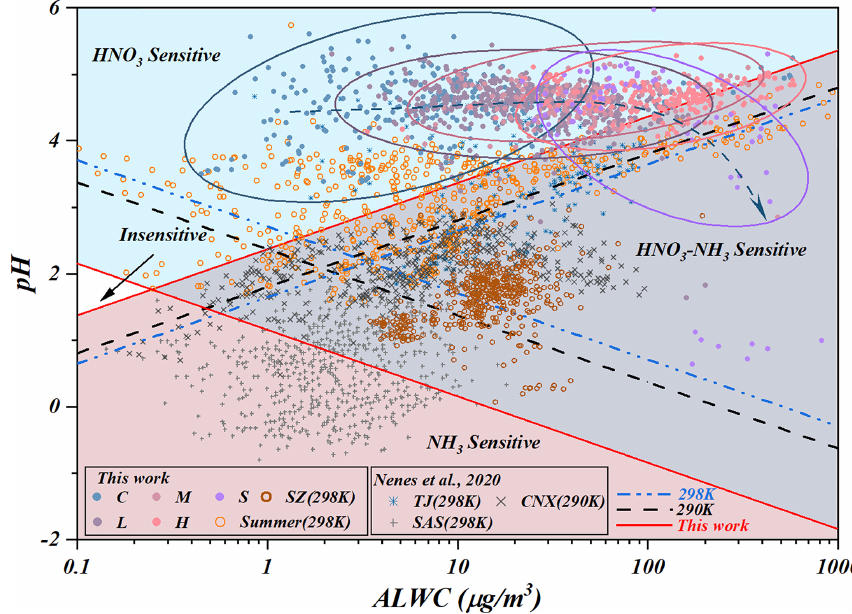
Figure 4. Chemical domains of aerosol response to ammonia and nitrate